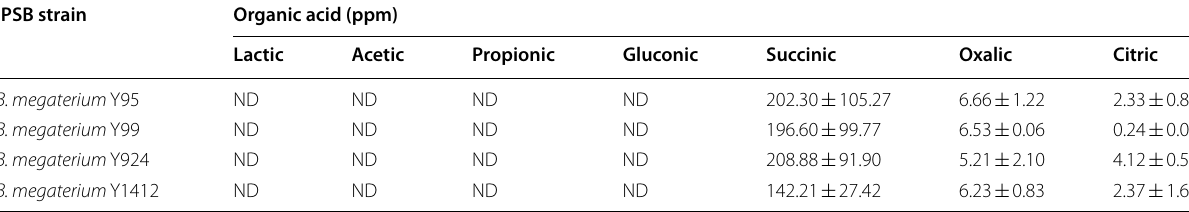
Table 3 Amounts of organic acids secreted by the four reference iPSB strains after incubation for 168